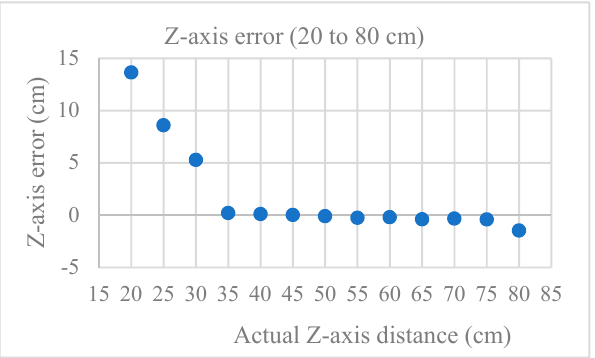
Figure 23. The schematic view of Condition 2, there are 4 measurement points in triggering area. In the first experiment, Condition 1 provided the measuring method, and the results of measurement errors were recorded in Figure 24, corresponding to the Z-axis distance ranging from 20 to 80 cm. When the Z-axis distance ranges from 20 to 35 cm, the error is obviously large. Until the Z-axis reaches farther than 80 cm, the error starts to rise again, but negatively. Figure 25 clearly indicates that the best working distance of this binocular camera is from 35 to 75 cm, within which the absolute values of average, maximum, and minimum errors are 0.22 cm, 0.42 cm, and 0.02 cm, respectively.